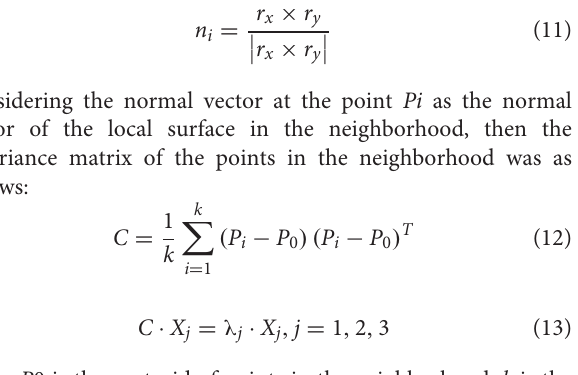
FIGURE 6 | Clustering segmentation extraction result: (A) result of the European clustering segmentation algorithm and (B) the target cabbage point